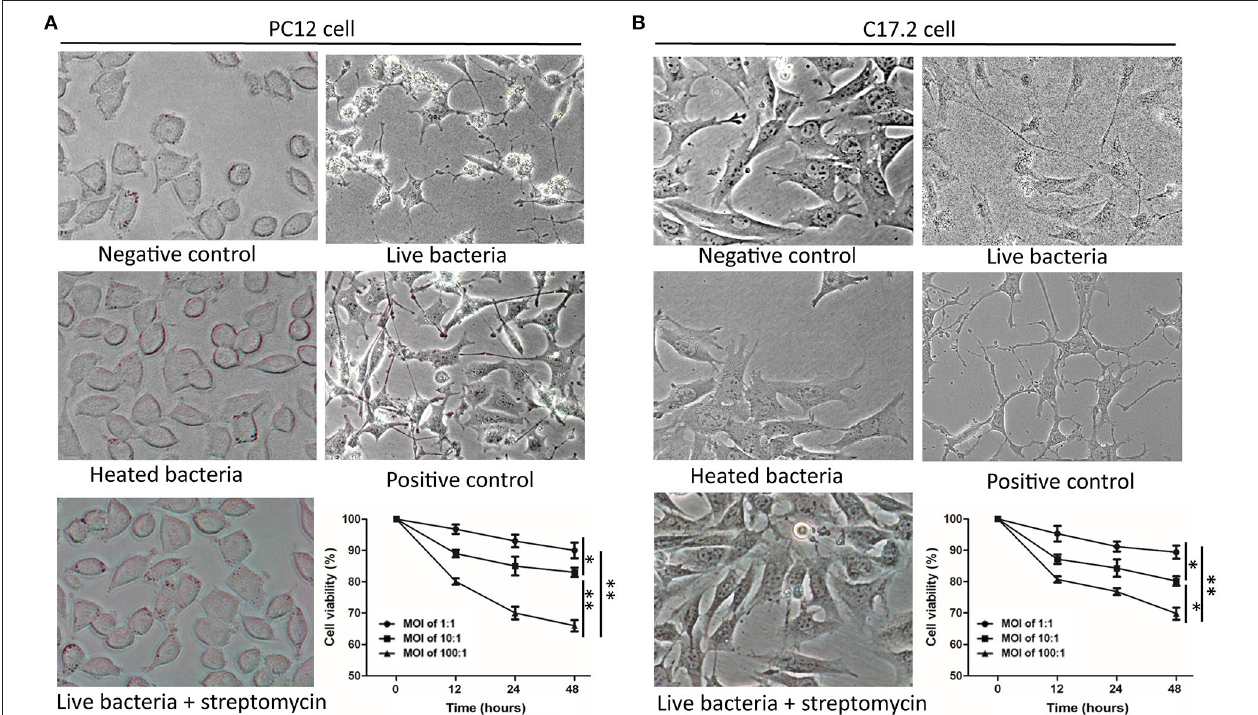
FIGURE 1 | M. smegmatis infection induced morphological changes of PC12 and C17.2 cells. M. smegmatis (MOI 10:1) were added to PC12 (A) or C17.2 (B) cells for 48h, cell morphologies were observed under different treatments ( × 40). 150ng/ml NGF was added in positive control of PC12 cells; 50ng/ml NGF and 50ng/ml BDNF were added to the positive control of C17.2 cells; Streptomycin (100 µ g/ml) and heat-killed M. smegmatis (MOI 10:1) were added as dead bacteria controls. Cell viability was measured by an MTT assay with indicated infection dose and time. Quantitative results are presented as means ± S.D. for 3 replicates. * P < 0.05, ** P < 0.01, vs. control group, n =